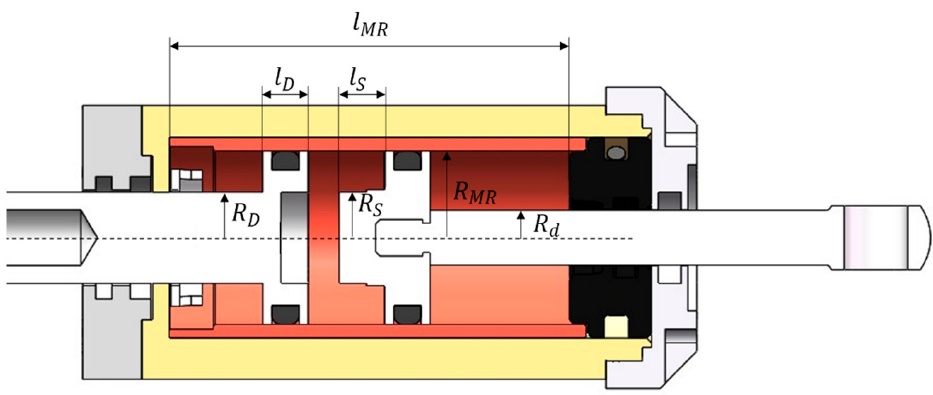
Figure 7. The parameters of the hydraulic cylinder. Table 1. The values of the parameters in simulation Parameters